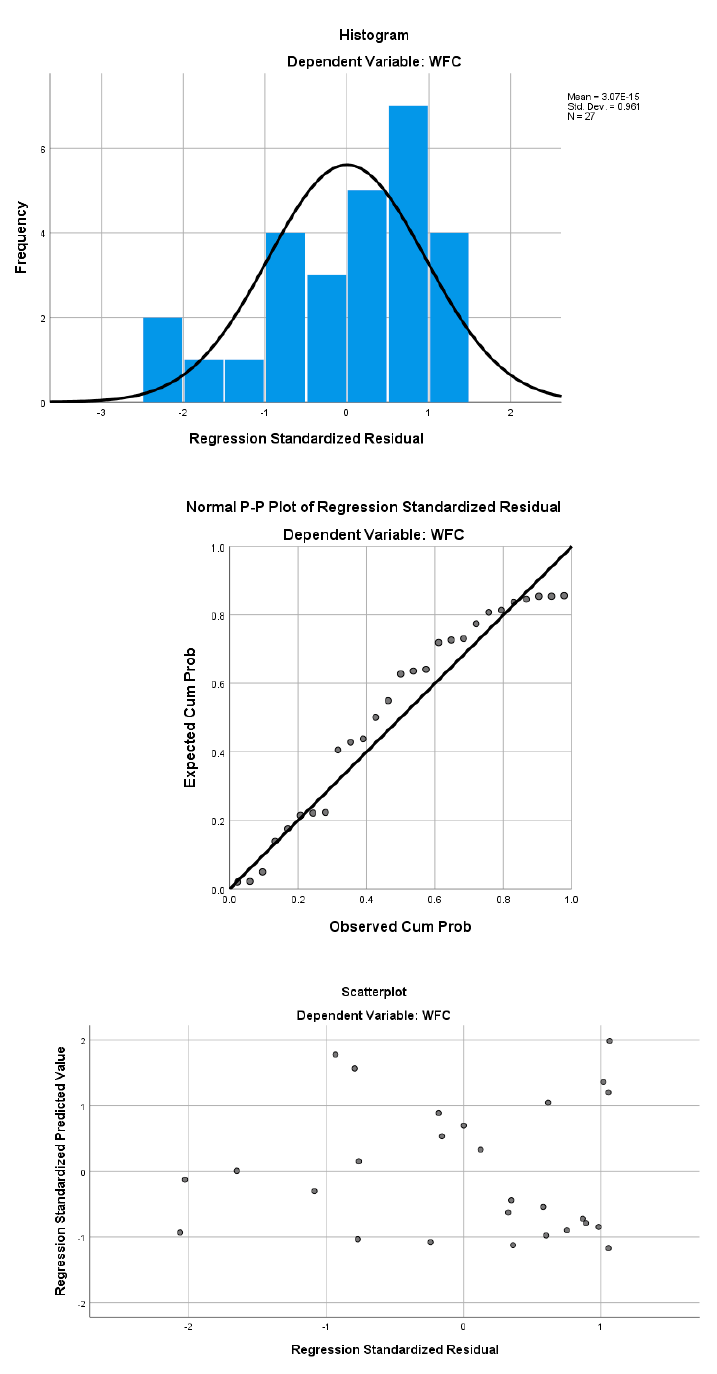
Figure A11. Model 2: WFC projection by GDP and Expo PM 2.5.